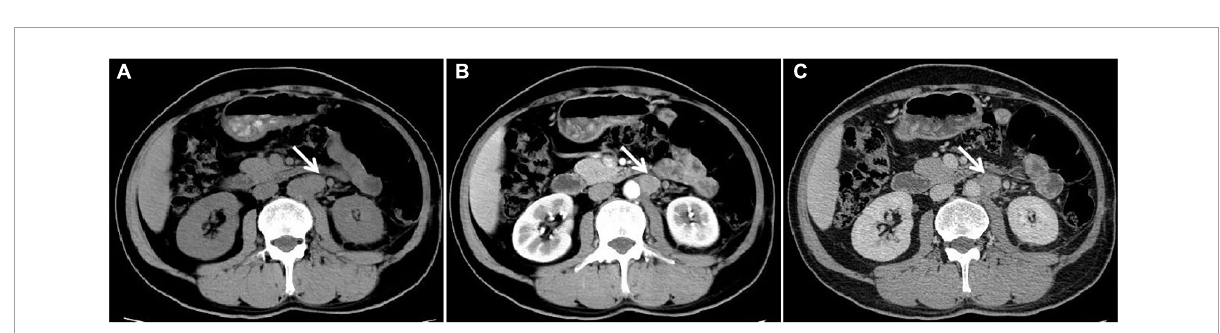
FIGURE4 Abdominal enhanced computed tomography (CT) findings at 6-month follow-up. Axial images from non-enhanced CT (A) to CT enhanced in arterial phase (B) and venous phase (C) . Non-enhanced CT (A) reveals the presence of a soft tissue density nodule in the surgical area (left para-abdominal aorta), CT enhanced in arterial phase (B) moderately enhanced nodules in the operative area, and decreased enhancement in venous phase (C) . No obvious abnormalities in either kidney are